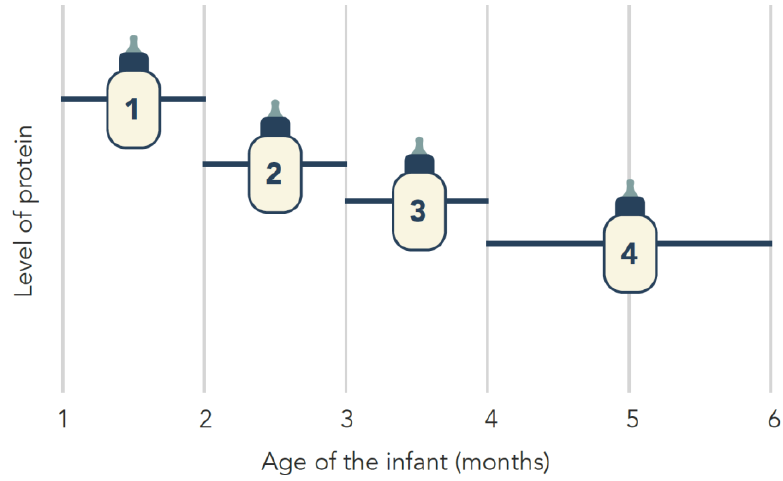
Figure 3. Staging concept: infant formula during the first 6 months of life.